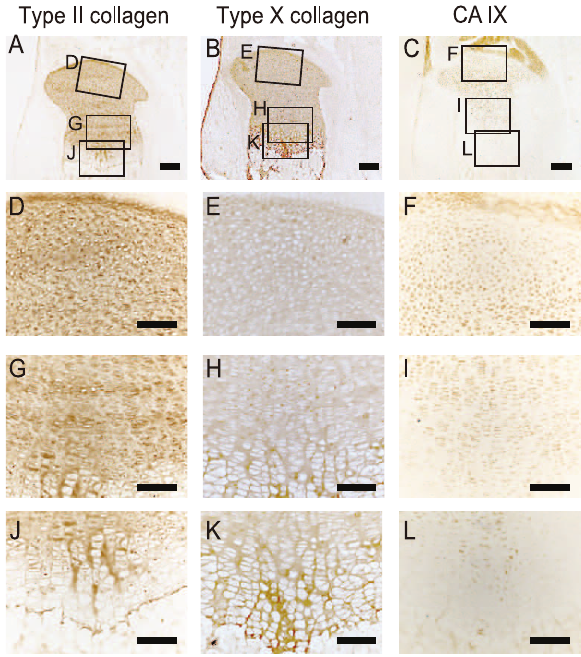
Figure 1. Localization of CA IX in epiphyseal cartilage. Frozen sections of lower limbs excised from 1-day-old postnatal ddY mice were analyzed for immunolocalization of type II collagen ( A , D , G , J ), type X collagen ( B , E , H , K ), and CA IX ( C , F , I , L ). Photographs show the entire epiphysis with lower magnification ( A – C ), regions containing stationary to round-shaped proliferating chondrocytes ( D – F ), columnar chondro- cytes proliferating to pre-hypertrophic chondrocytes ( G – I ), and hypertrophic chondrocytes ( J – L ) at higher magnifications. The regions magnified ( D – L ) were shown in the photographs of the entire epiphysis ( A – C ). Bars are 0.2 mm (A–C) and 0.1 mm